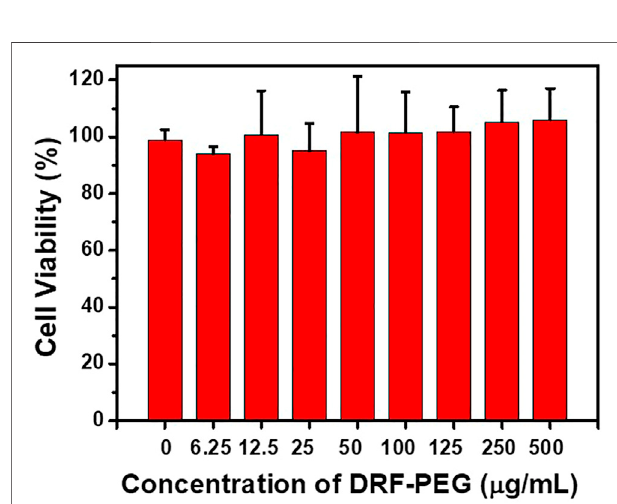
FIGURE 6 | Cell viability values of human cervical carcinoma cells (HeLa) vs. the concentration of DRF-PEG. HeLa cells were incubated with different concentrations of DRF-PEG (0 – 500 μ g/ml) for 24